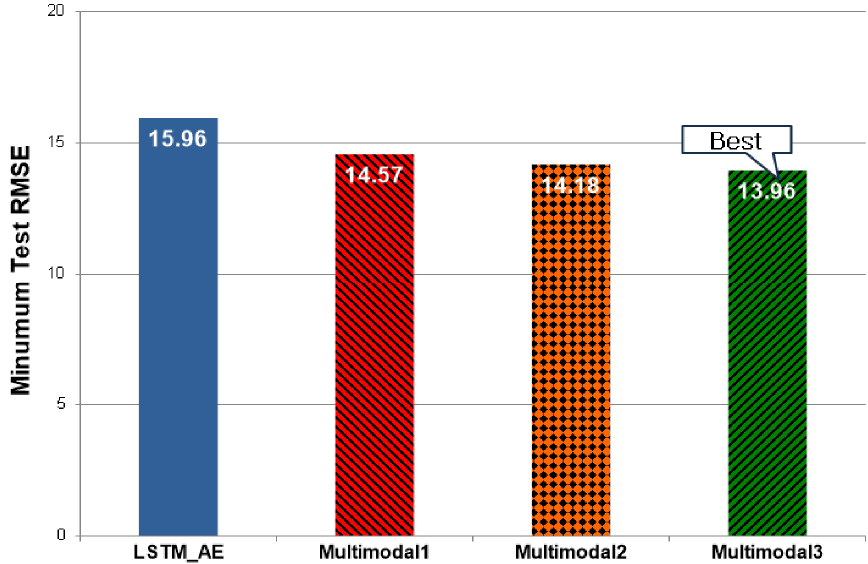
Figure 9. Minimum Test RMSE for proposed models using the original image.